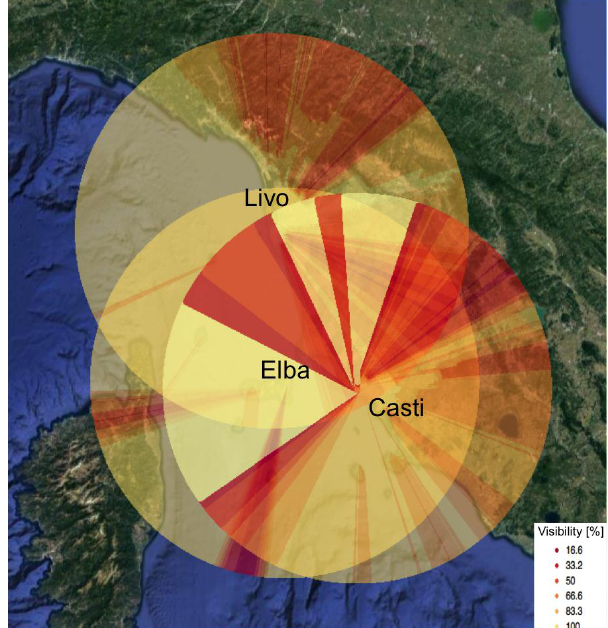
Figure 1. Simulated visibility map of the Tuscan X-band weather radar network over the whole coverage area considering a scan elevation angle of 1.5° (Livo: Livorno, Elba, and Casti: Castiglione della Pescaia radars).